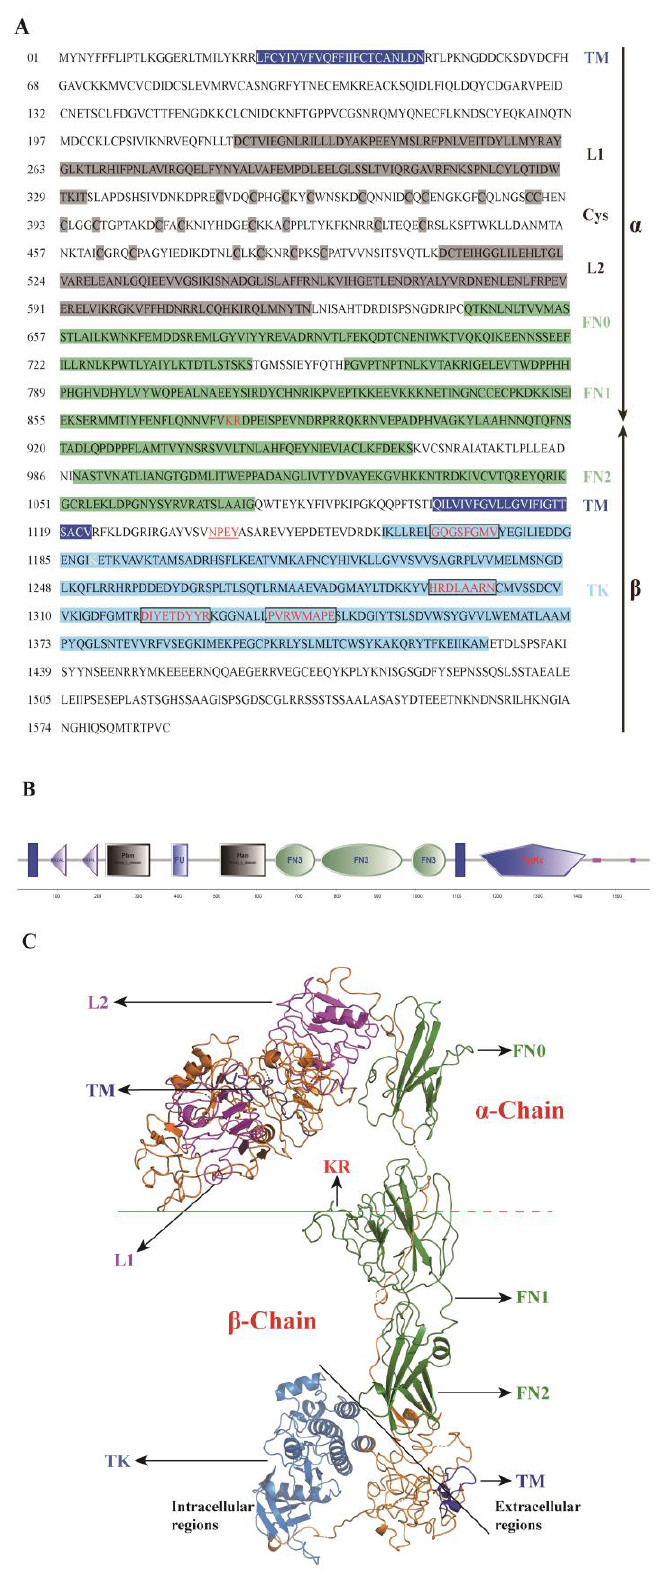
Figure 1. Amino acid sequence ( A ), structural feature ( B ), and three-dimensional (3D) structure ( C ) of SjILPR . ( A ) The dibasic site KR is highlighted in red script. The transmembrane domains are shown in white script on blue background. Indicated are the ‘L1–Cys–L2 (cid:48) structure (gray background), three fibronectin III domains (light green background), and the tyrosine kinase domain (light blue background). Juxtamembrane NPEY motif is highlighted in the red script and underlined.